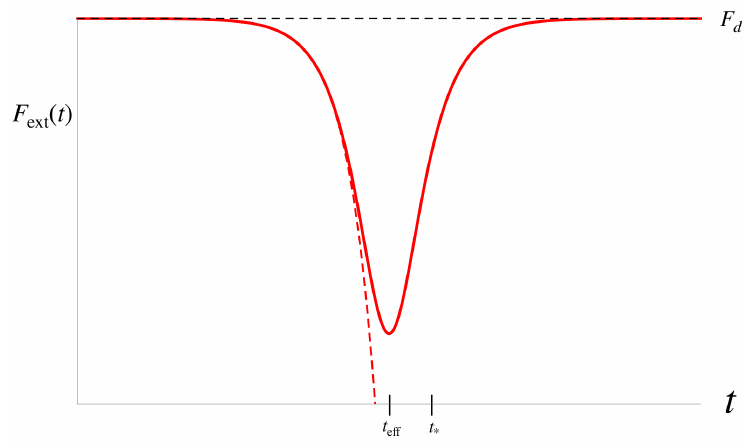
Figure 1 . The extremally chaotic OTOC F ext ( t ) coincides with the maximally chaotic OTOC (red dashed line) only before the effective time scale t at t = t , irrespective of the scrambling time t eff approaching the factorized value (also the initial value) F correlator F for real t even after the scrambling d